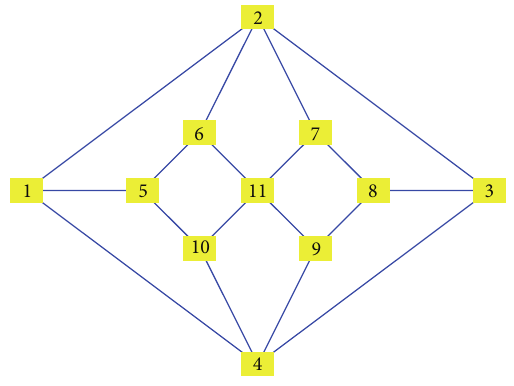
Figure 1: Herschel graph: original style.